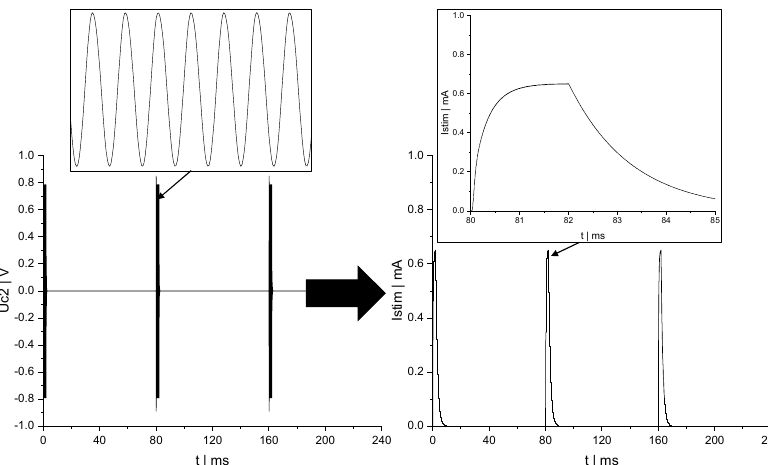
Figure 3. Exemplary representation of the pulsed inductive power supply of the implantable elec- tronics. Induced voltage u C2 (t) ( left ) and rectified stimulation current i Stim (t) ( right ) versus time t. The root mean square of the induced voltage Uc2 across the circuit topology of ceramic capacitors and the root mean square of the voltage across the load R L , leading to the stimulation current Istim, were measured in a time span between 0.4 ms and 0.8 ms using the Tektronix MDO4104-6 (Tektronix, Inc., Beaverton, OR, USA) oscilloscope and two TESTEC TT-MF312-2-6 11020-2-6 (TESTEC Elektronik, GmbH, Frankfurt, Germany)